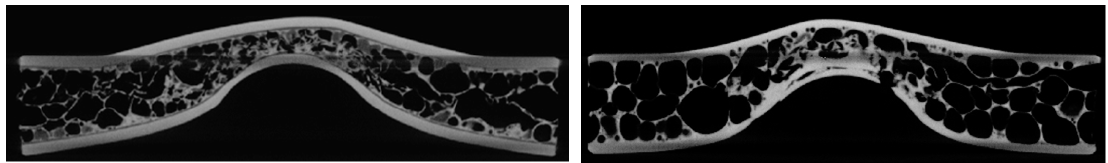
Figure 16: Tomographic images of the damaged AFS panels (left Alulight ; right Schunk ) after the impact (v = 4